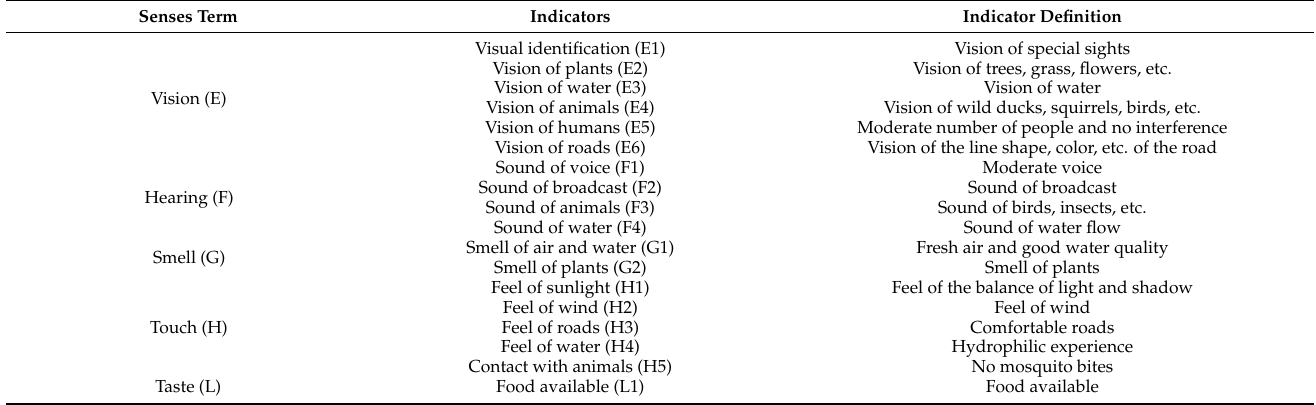
Table 2. Evaluation index system of sensory